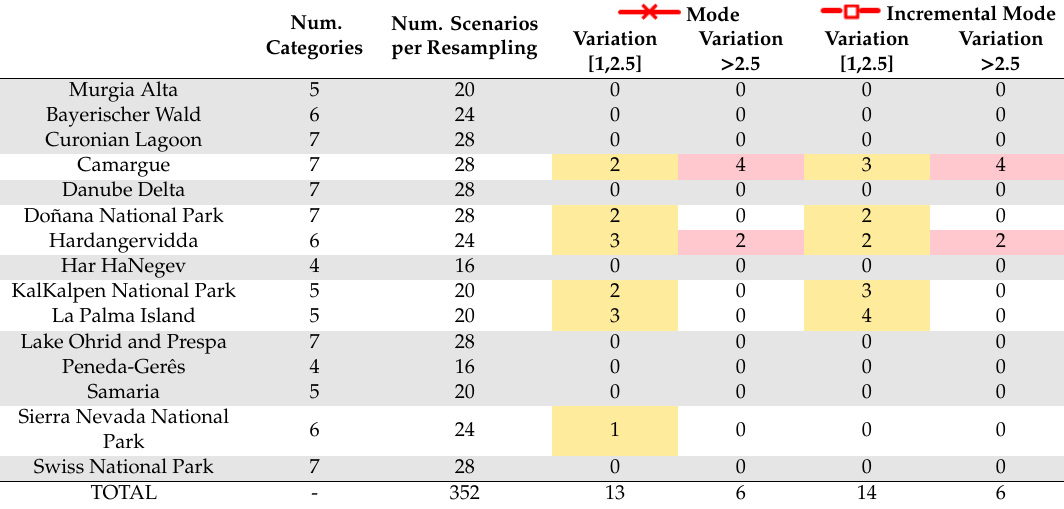
Table 3. Number of scenarios with an absolute maximum variation for each PA for all resolutions and for all categories that have a deviation between 1 and 2.5 percentage points and higher than 2.5 percentage points. The yellow background highlights scenarios with an absolute variation between 1 and 2.5 percentage points, and the red background highlights scenarios with a variation higher than 2.5.